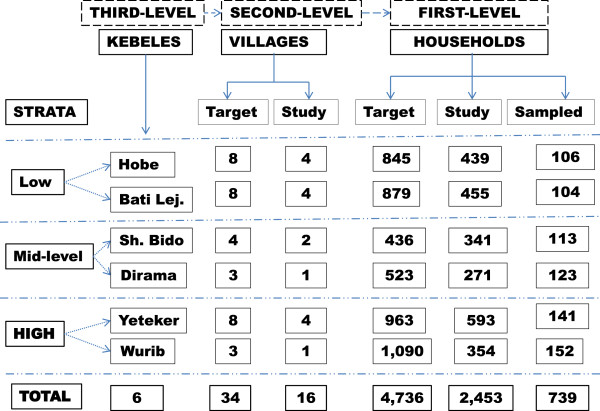
Framework of the study design.